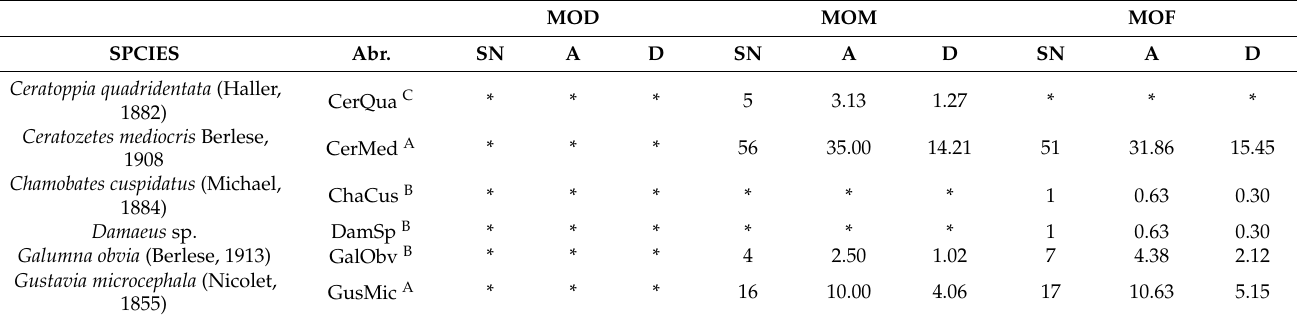
A total of 32 species of oribatid mites were recorded (MOF 62.5%, MOM 74.9%, MOD 9.4%, MOS 0.0%). In the sample MOS, we did not find any representative of the oribatid mites. In the sample MOD, we recorded only three species. Opiella (Moritzoppia) translamellata (Willmann, 1923) and Poecilochthonius italicus (Berlese, 1910) were found in the sample MOD in very low abundance, while the eurytopic species Tectocepheus velatus sarekensis (Trägårdh, 1910) was numerous. Oribatocoenoses MOF and MOM were formed mainly by species of moist meadow and forest habitats (Table 3). Table 3. The list of Oribatida species found at each of three sampling sites near the coal ash basin (listed in alphabetical order). No individual (*) was found in the sample MOS. SN, species number; A, abundance; D,